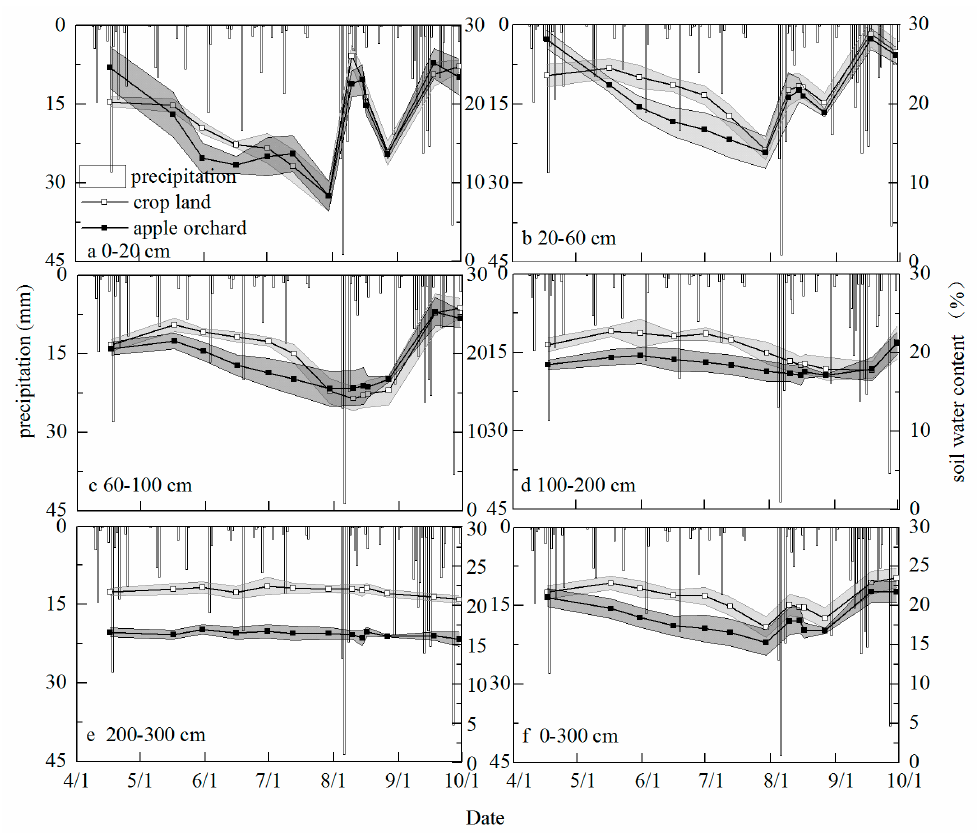
Figure 5. The variations in soil water content in different layers. ( a ) 0–20 cm; ( b ) 20–60 cm; ( c )